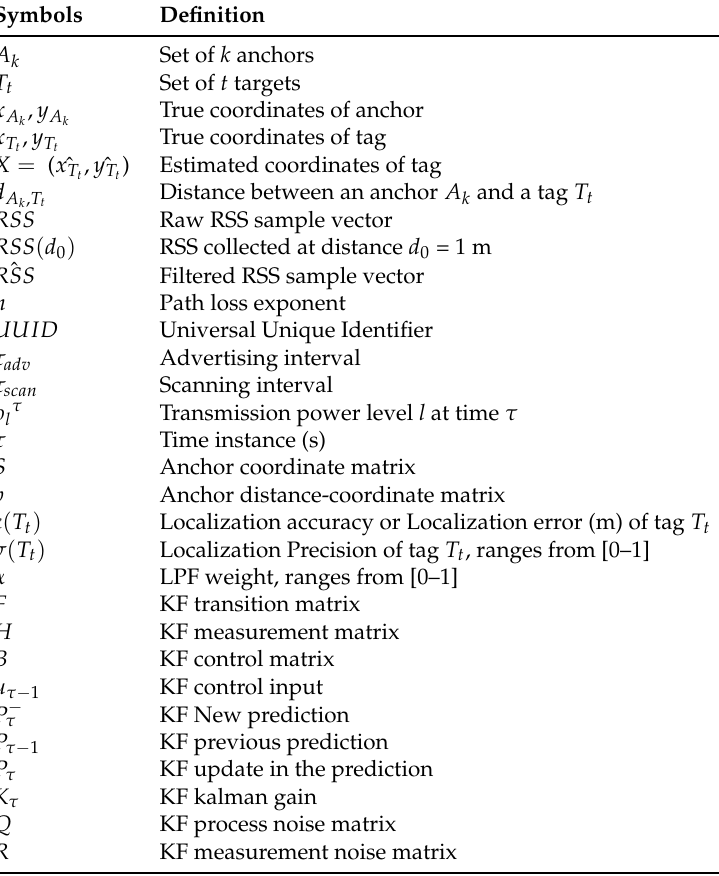
Table 2. Symbols and